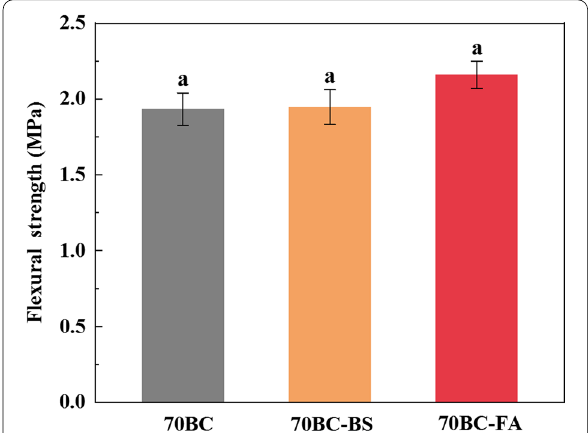
Fig. 5 Flexural strength of the MOSC biochar particleboards